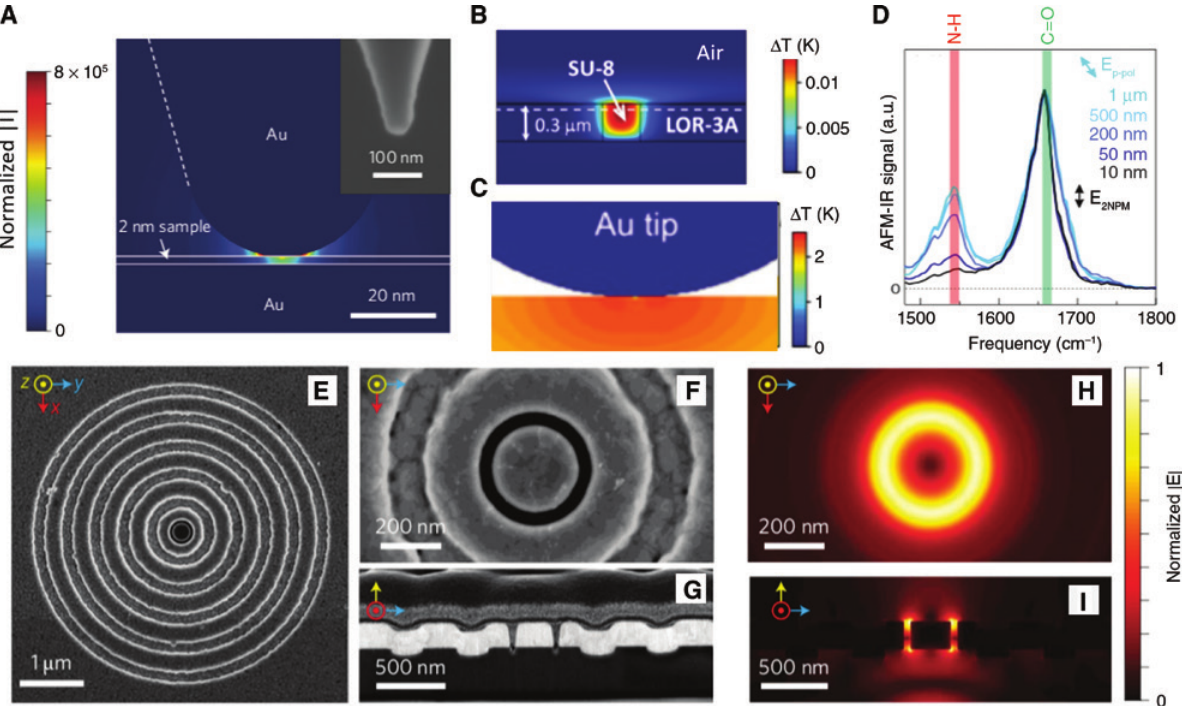
Figure 5: Plasmonic nanostructures to enhance microscopic optical forces [55, 57, 59, 60]. (A) Optical field simulation of monolayer sample with the thickness of 2 nm. (B) Simulation of temperature elevation of sample with the thickness of 0.3 μ m enhanced by a gold tip. (C) Temperature simulation of sample with the thickness of 10 nm. (D) AFM-IR spectra acquired on purple-membrane films of various thickness from 10 nm to 1 μ m. (E–G) Scanning electron microscopy (SEM) images of bull’s eye grating- flanked coaxial nanoaperture. (H, I) Finite difference time domain simulations of the field distribution on resonance of the nanoaperture (Figures adapted from Refs. [55, 57, 59,